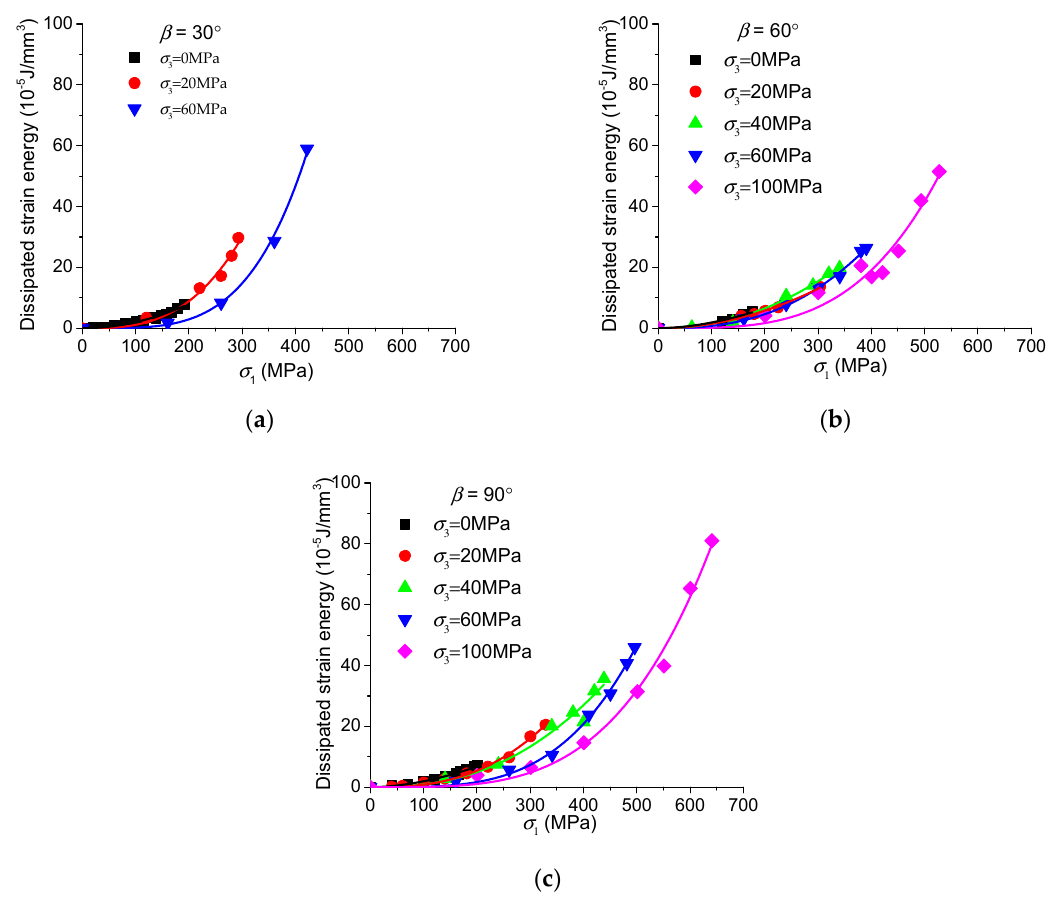
Figure 9. Dissipated strain energy with the increase of axial stress for the shale samples with different oriented weak planes (( a ) β = 30 ° , ( b ) β = 60 ° , and ( c ) β = 90 °) under various confining pressures.